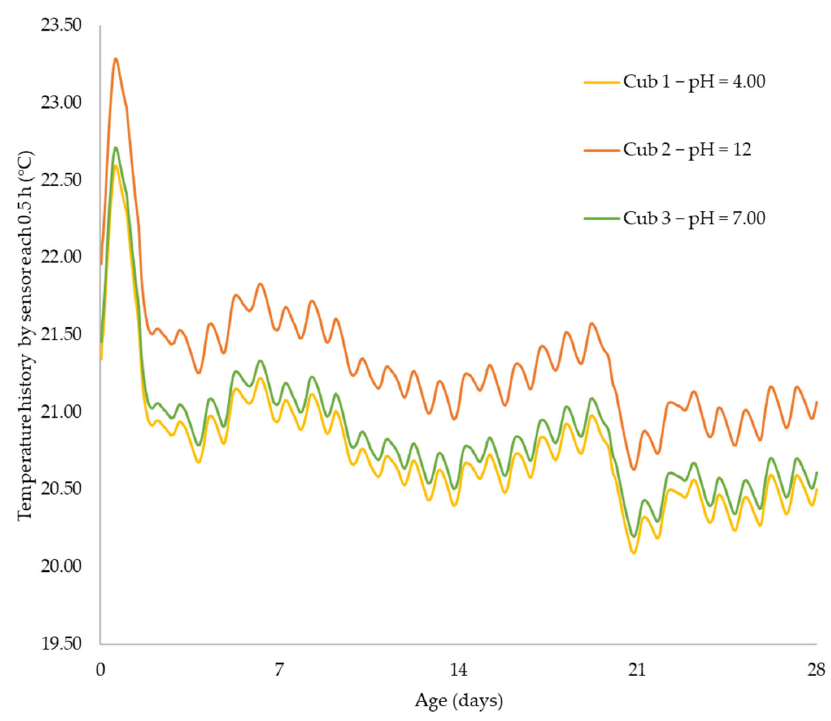
Figure 4. Temperature data with time recorded by the sensor after every time interval of 0.5 h.